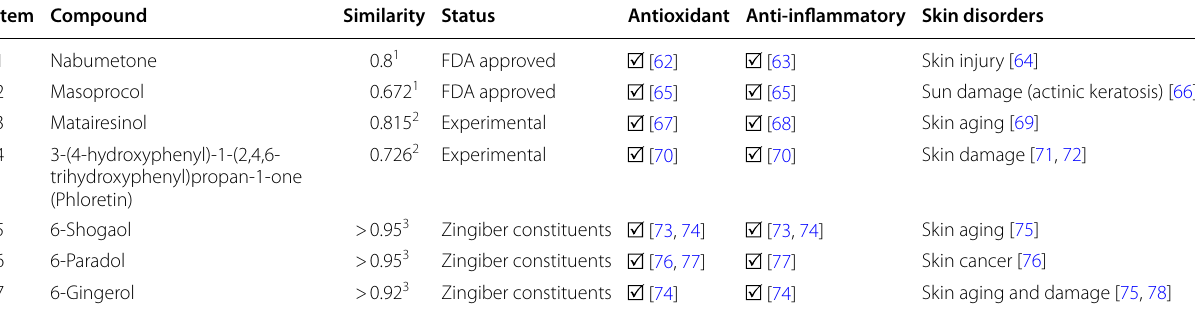
Table 1 The list of identified compounds from SwissSimilarity and PubChem structure similarity accompanied by their anti-oxidant, anti-inflammatory, and related skin